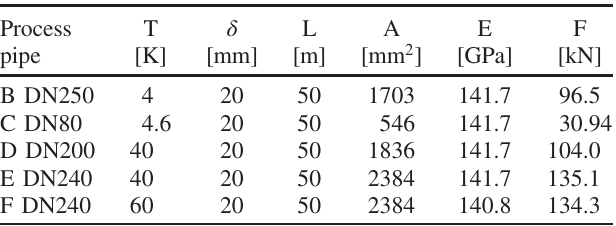
TABLE VI. Comparison of total heat leaks through the sup- ports to each of the process